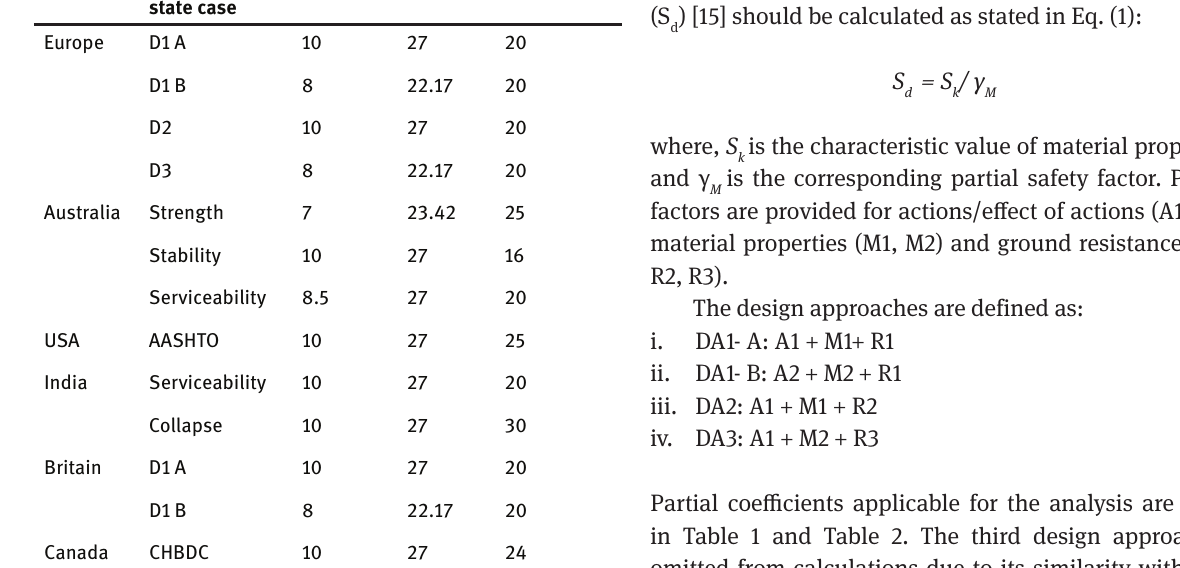
Table 3: Factored values of material properties. CODE